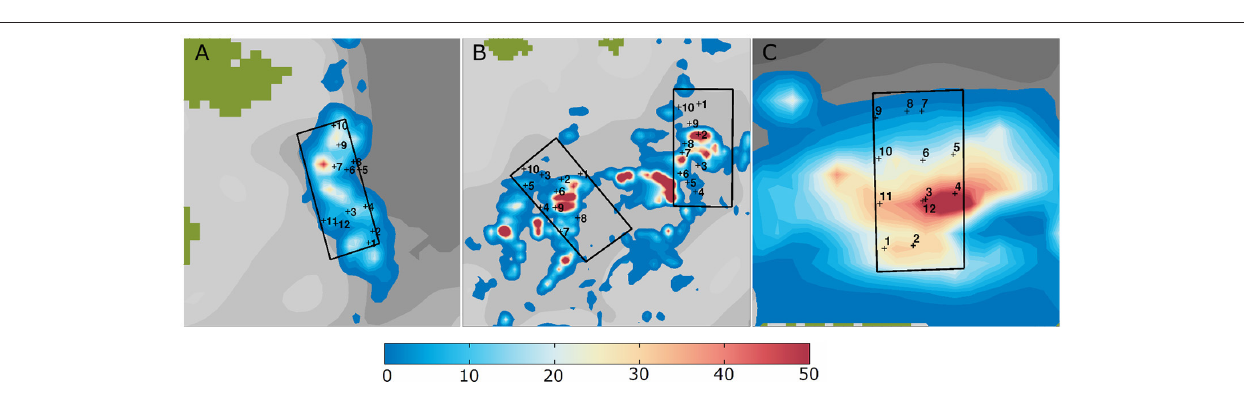
Frontiers in Marine Science | www.frontiersin.org